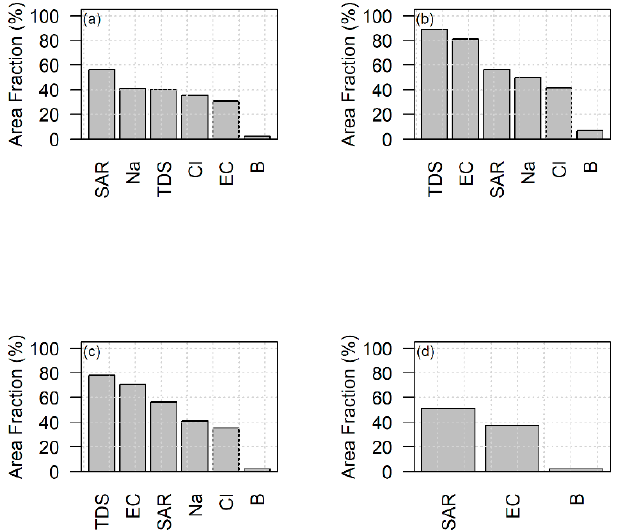
Figure 9. Fraction of incompatibility per constituent of concern for agricultural water use—( a ) cotton, ( b ) corn, ( c ) sorghum, and ( d ) winter wheat.